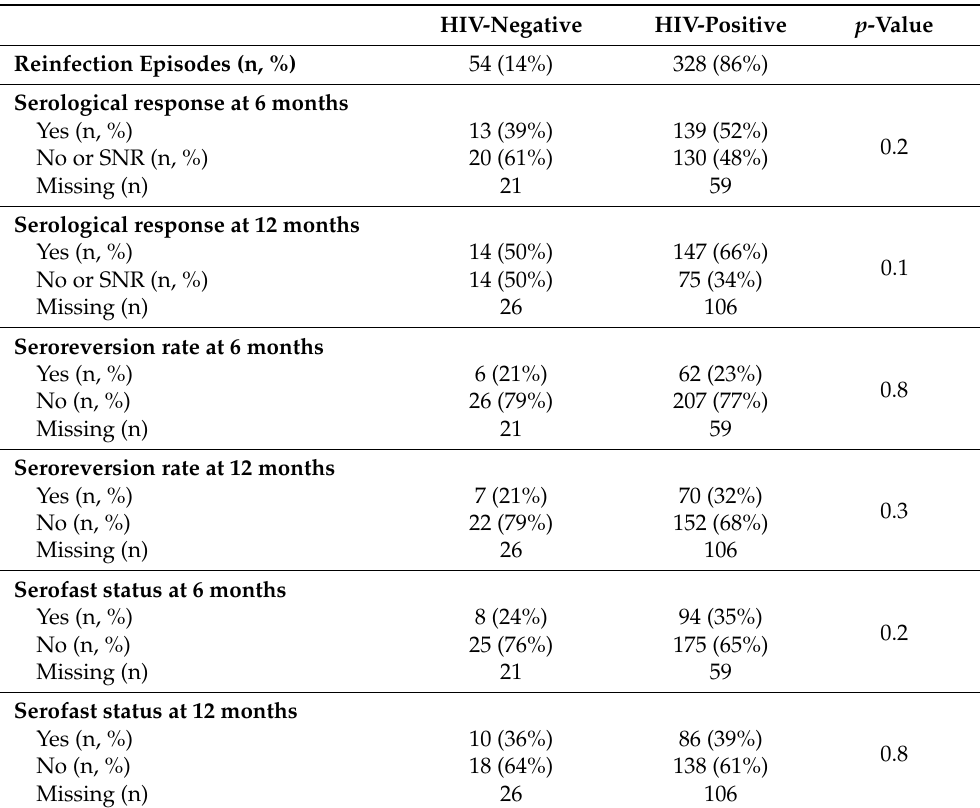
Table 4. Serological response to treatment after syphilis reinfection at 6- and 12-month follow-up (SNR = serological non-response). HIV-Negative HIV-Positive p